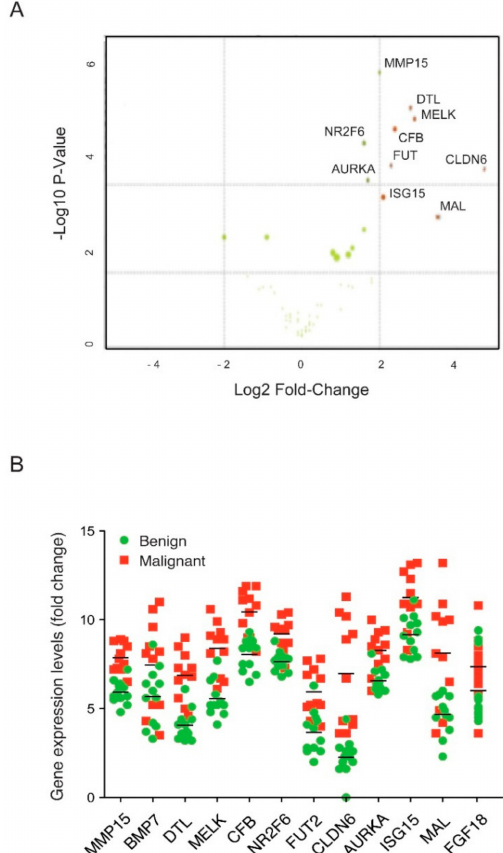
Figure 3. Validation of biomarker candidates in tissue and blood. ( A ) This plot depicts the Log–Fold changes and P -values of di ff erential biomarker expression values between malignant (positive values) and benign tissue (negative values). The top 10 significant ( P -value significance ≥ ~1.3) candidate biomarkers are labelled. ( B ) The distribution of gene expression levels of biomarker candidates matrix metalloproteinase 15 (MMP15), bone morphogenetic protein 7 (BMP7), denticleless E3 ubiquitin protein ligase (DTL), maternal embryonic leucine zipper kinase (MELK), complement factor B (CFB), nuclear orphan receptor (NR2F6), galactoside 2-alpha-L-fucosyltransferase-2 (FUT2), claudin-6 (CLDN6), aurora kinase A (AURKA), interferon-stimulated gene 15 (ISG15), myelin and lymphocyte protein (MAL), fibroblast growth factor 18 (FGF18) in benign and ovarian cancer tissues are shown ( p < 0.05). The expression data were obtained by NanoString analysis using the mRNA from tissue samples of patients with benign ( N = 10) disease or ovarian cancer ( N =